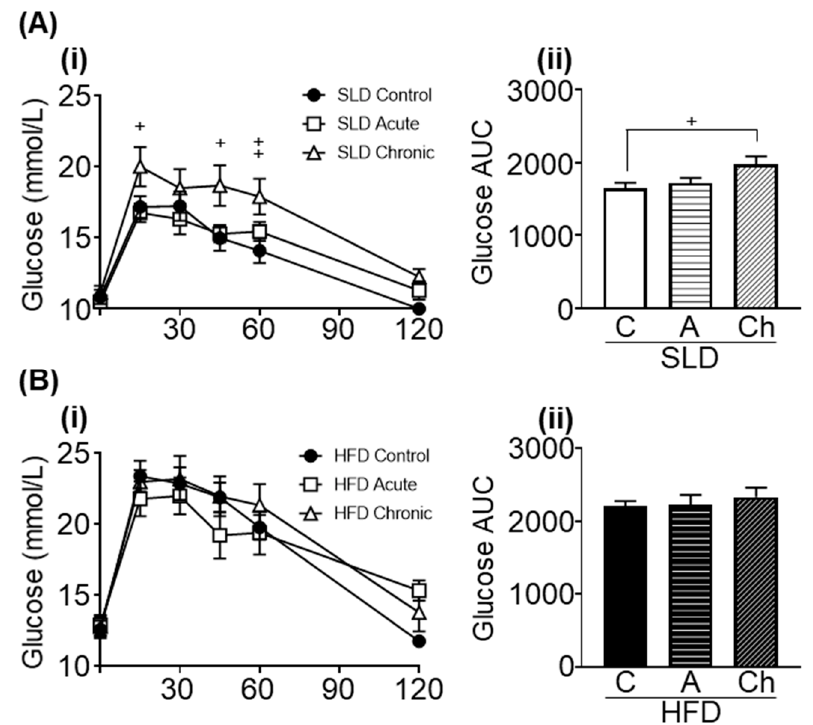
Figure 5. Acute (A) and chronic (Ch) isoleucine treatment differentially affects glucose tolerance. ( i ) Blood glucose levels in response to an oral glucose tolerance test and ( ii ) glucose area under curve (AUC) in ( A ) standard laboratory diet (SLD) and ( B ) high fat diet (HFD)-mice. (SLD/HFD-Control (C) n = 8–10, SLD/HFD-A n = 8–10 and SLD/HFD-Ch n = 8–10). Values are mean ± SEM. + p < 0.05, one-way ANOVA.